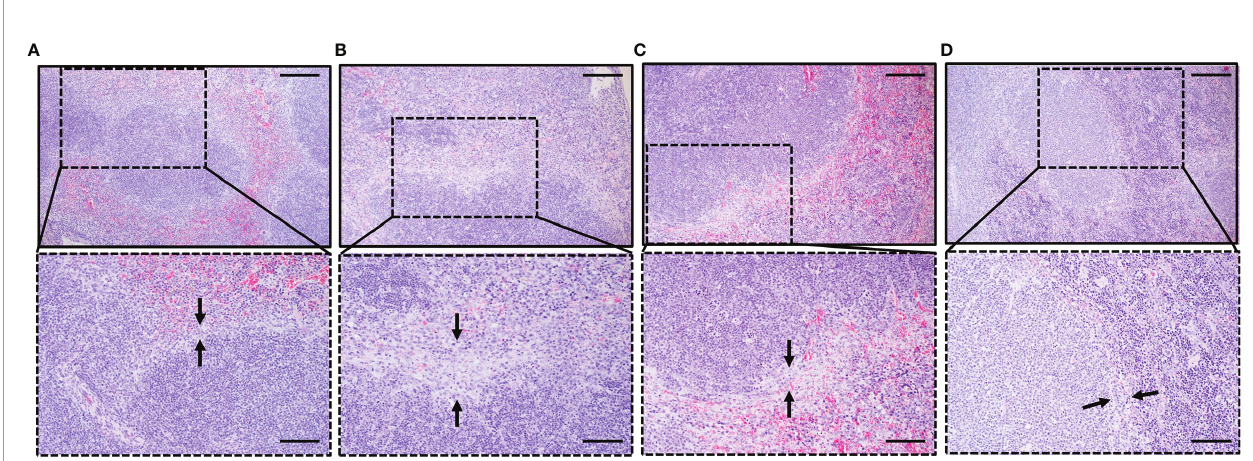
FIGURE 6 | Histopathological analysis of the spleen depicting the impact of B . microti , B . rodhaini , and co-infection on the spleen compared to uninfected mice. Sections collected on day 6 post-challenge infection were stained with H & E, 100× and 200×. Black arrowheads indicate the variations in the marginal zone relative to (A) Naive mouse group. Erosion of the marginal zone in terms of loss of cellularity was found to be more pronounced in (B) Br mice compared to (C) bm/br4, and (D) bm/br6 mice. Bars in upper and lower images represent 200 and 100 m m,